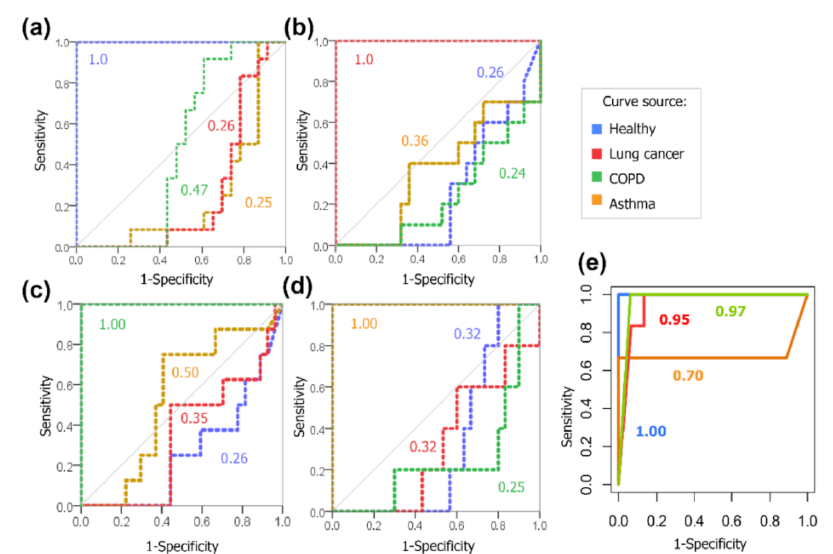
Figure 6. ROC curves generated from fitted values (train set) created by MLR model, labelling ( a ) healthy, ( b ) lung cancer, ( c ) COPD and ( d ) asthma as the state variables; ( e ) ROC curves generated from predictions computed by the MLR model for the test set. Colored numerals refer to values of AUC obtained for each depicted